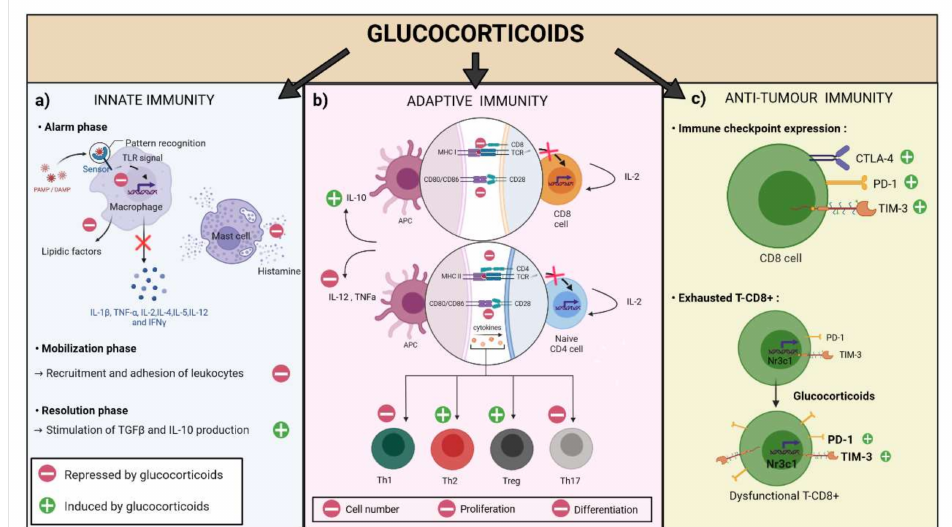
Figure 3. Effect of glucocorticoids on the immune system. Glucocorticoids have a role on innate, adaptive, and antitumour immunity. ( a ) On innate immunity, during the alarm phase, they inhibit toll like receptor (TLR) signalling, which prevents the production of proinflammatory cytokines. In addition, they inhibit the release of histamine from mast cells. The mobilization phase is impacted by a decrease in leukocytes recruitment and adhesion. The resolution phase is characterized by an increased production of TGF β (Transforming growth factor β ) and interleukin 10 (IL-10). ( b ) On adaptive immunity, glucocorticoids play an important role because they inhibit the co-stimulation of the antigen-presenting cell (APC) to T-CD8+ or T-CD4+ lymphocytes by decreasing the expression of major histocompatibility complex (MHC) type I and II molecules and decreasing the expression of CD28 and CD80 molecules. In addition, T-cell proliferation is decreased by alteration of T-cell receptor (TCR)-initiated signalling and thus decreased IL-2 production. Glucocorticoids also have a role on the polarization and differentiation of naive CD4-T cells by inhibiting T helper 1 (Th1) and 17 (Th17) differentiation and promoting T helper 2 (Th2) and T regulator (T-reg) differentiation. ( c ) On anti-tumour immunity, glucocorticoids induce the expression of immune checkpoints, such as the cytotoxic T-cell associated protein 4 (CTLA4), programmed death receptor 1 (PD-1), and mucin-3 T-cell immunoglobulin (Tim-3). They also promote an exhausted and therefore dysfunctional phenotype of CD8+ lymphocytes through the co-expression of PD-1 and TIM-3 receptors (created with